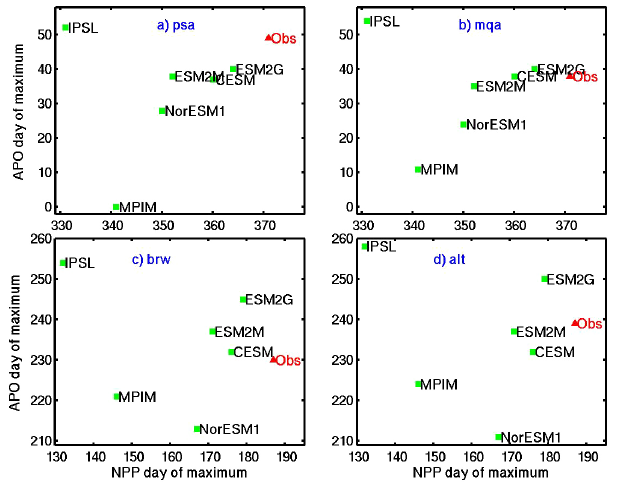
Figure 7. Day of APO maximum plotted against day of NPP maximum. The observed data point is derived from APO data at (a) Palmer Station, (b) Macquarie Island, (c) Barrow and (d) Alert plotted against satellite NPP data integrated over the 40–60 ◦ lati- tude band of the appropriate hemisphere.